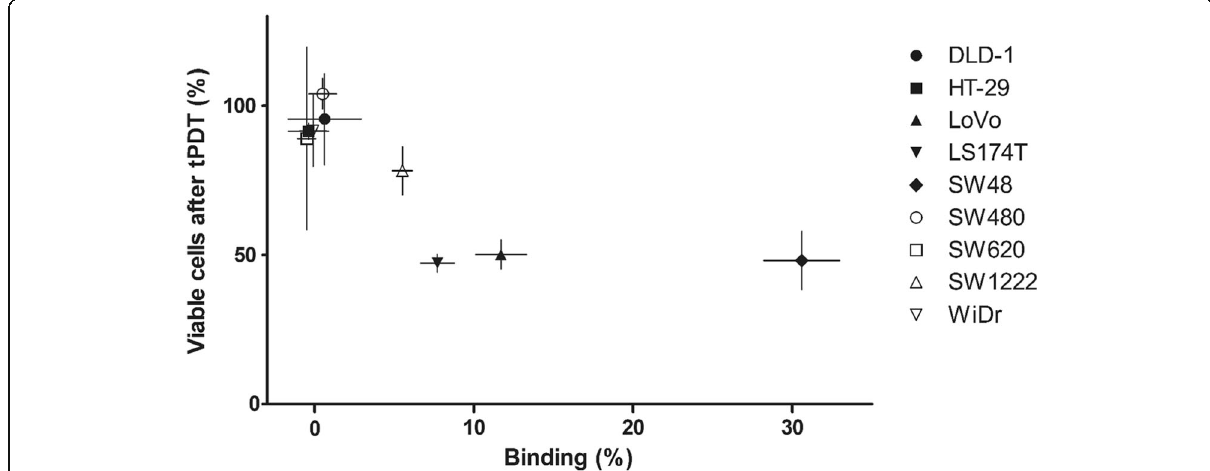
Fig. 2 Relation between the tPDT effect (amount of remaining viable cells 1 h after treatment) and antibody conjugate binding (expressed as percentage of the total amount of added antibody conjugate) for the nine different cell lines. Note that in general more binding (more accessible/targetable CEA sites) leads to a greater effect of tPDT (fewer viable